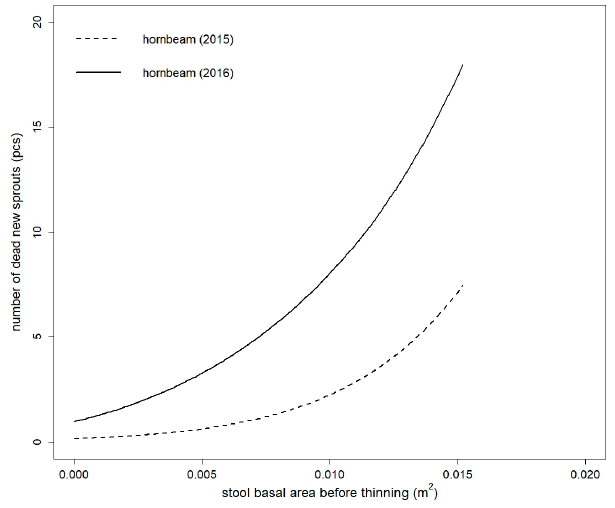
Figure 4. Comparison of fitted values of dead new sprouts model of European hornbeam in both studied years. Models are based on the stool basal area before thinning (for both years) and thinning intensity (only for year 2015) (for the purpose of this figure, thinning intensity = 48.8586%—mean value for European hornbeam).